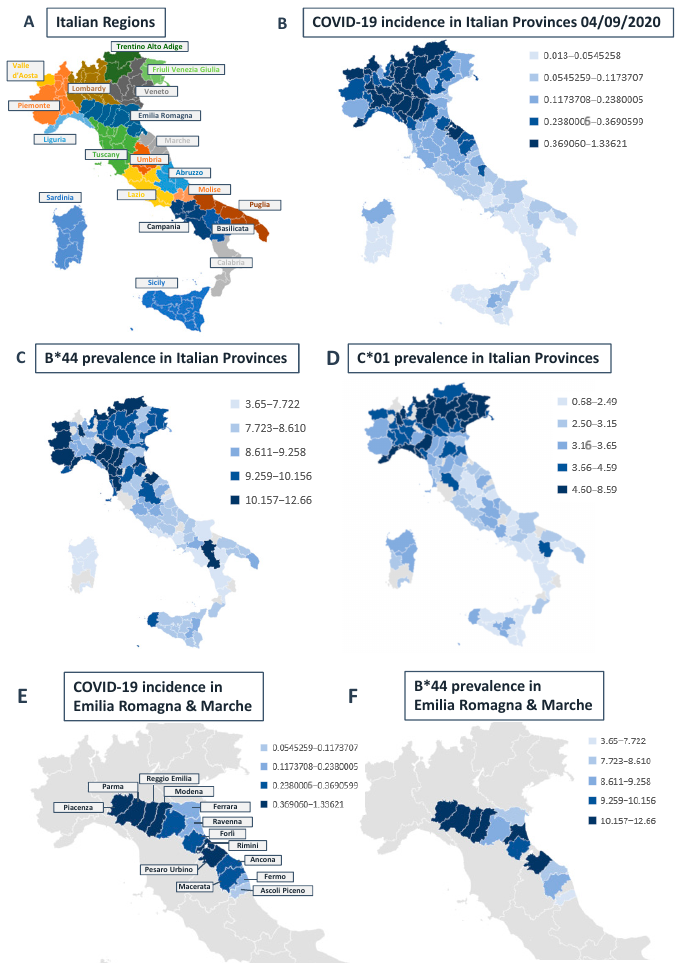
Figure 1. COVID-19 incidence, human leukocyte antigen (HLA)-B*44 and C*01 prevalence in Italian Provinces. ( A ): The graphical map shows the twenty Italian regions each constituted by various provinces. ( B ): The graphical map shows quintiles of COVID-19 incidence across Italian provinces. Incidence data were calculated as the number of laboratory-confirmed COVID-19 cases up to 04 / 09 / 2020 divided by the number of residents, according to the o ffi cial national data (supplementary data). ( C , D ). The graphical maps show B*44 and C*01 prevalence (%) in Italian Provinces. ( E , F ) The graphical maps show COVID-19 incidence and B*44 prevalence (%) in the provinces of Emilia Romagna and Marche. Geographical maps were built through Microsoft Excel. All COVID-19 incidence and HLA prevalence values are reported as Supplementary